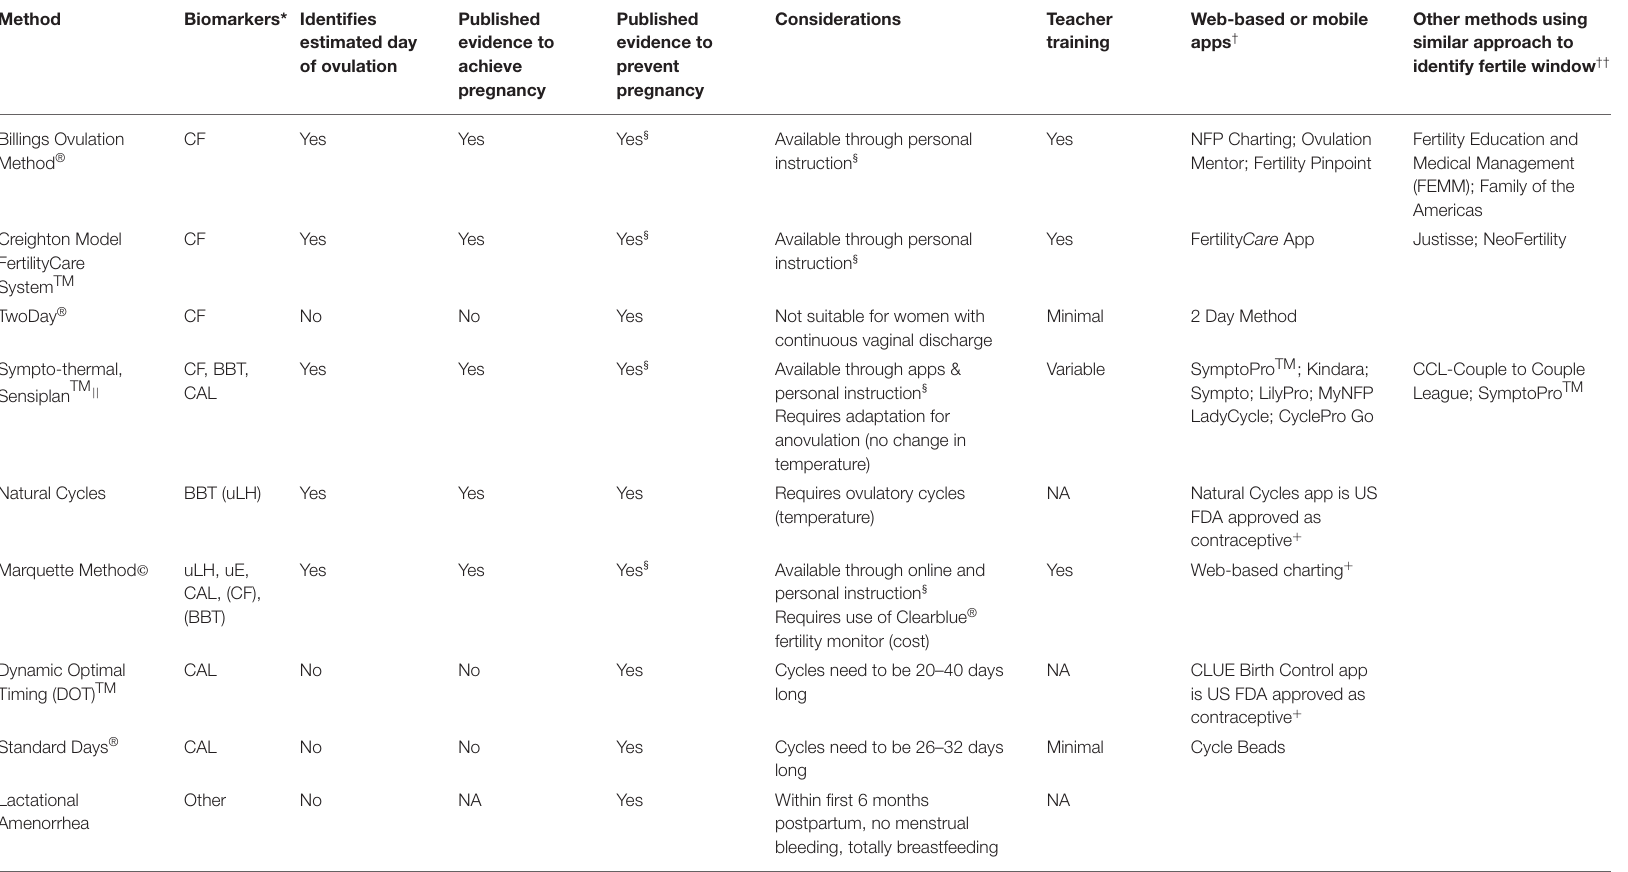
TABLE 1 | Overview of fertility awareness-based methods